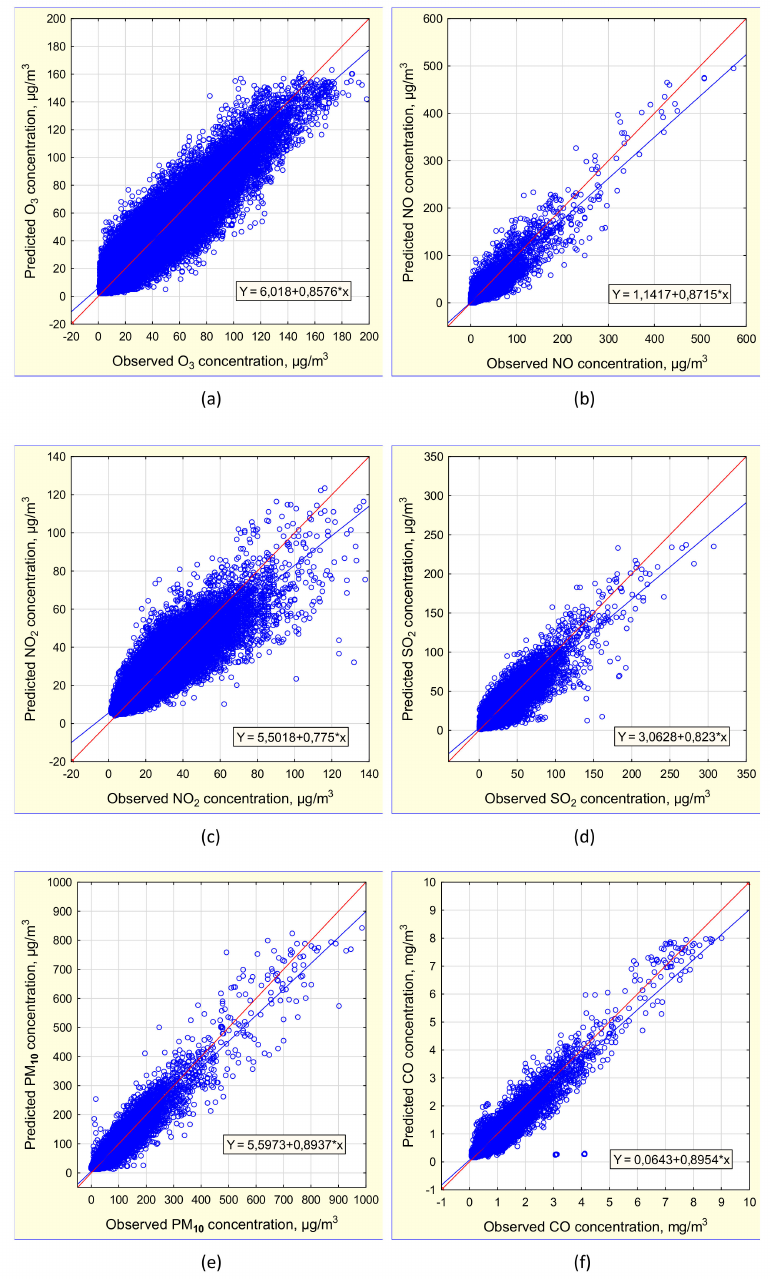
Figure 3. Scatterplots of observed and predicted concentration values; ( a ) scatterplot for O 3 ; ( b ) scatterplot for NO; ( c ) scatterplot for NO 2 ; ( d ) scatterplot for SO 2 ; ( e ) scatterplot for PM 10 ; ( f ) scatterplot for CO; the explicit form of the regression equations are included in the legends; a red line for equations y = x; a blue line for regression